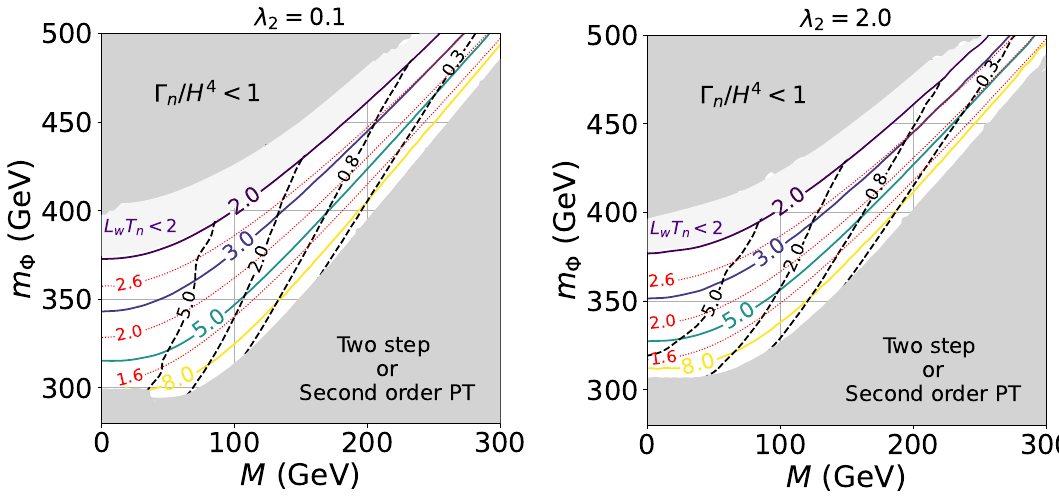
Figure 3 . The behavior of the electroweak phase transition for various masses of the additional Higgs bosons and the decoupling parameter M . The masses of the additional Higgs bosons are assumed to be degenerated and given by m . The red dotted lines are contours for v Φ black dashed lines are 10 × ∂ . Other colored lines are contours for L z θ | max figure, λ is set to be 0.1 2